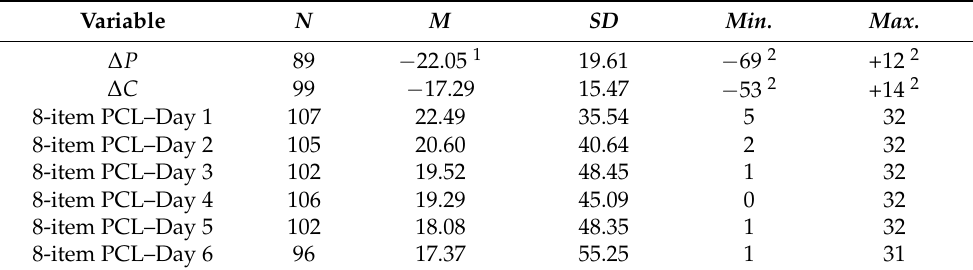
Table 2. Descriptive data for the follow-up treatment outcomes and the daily 8-item